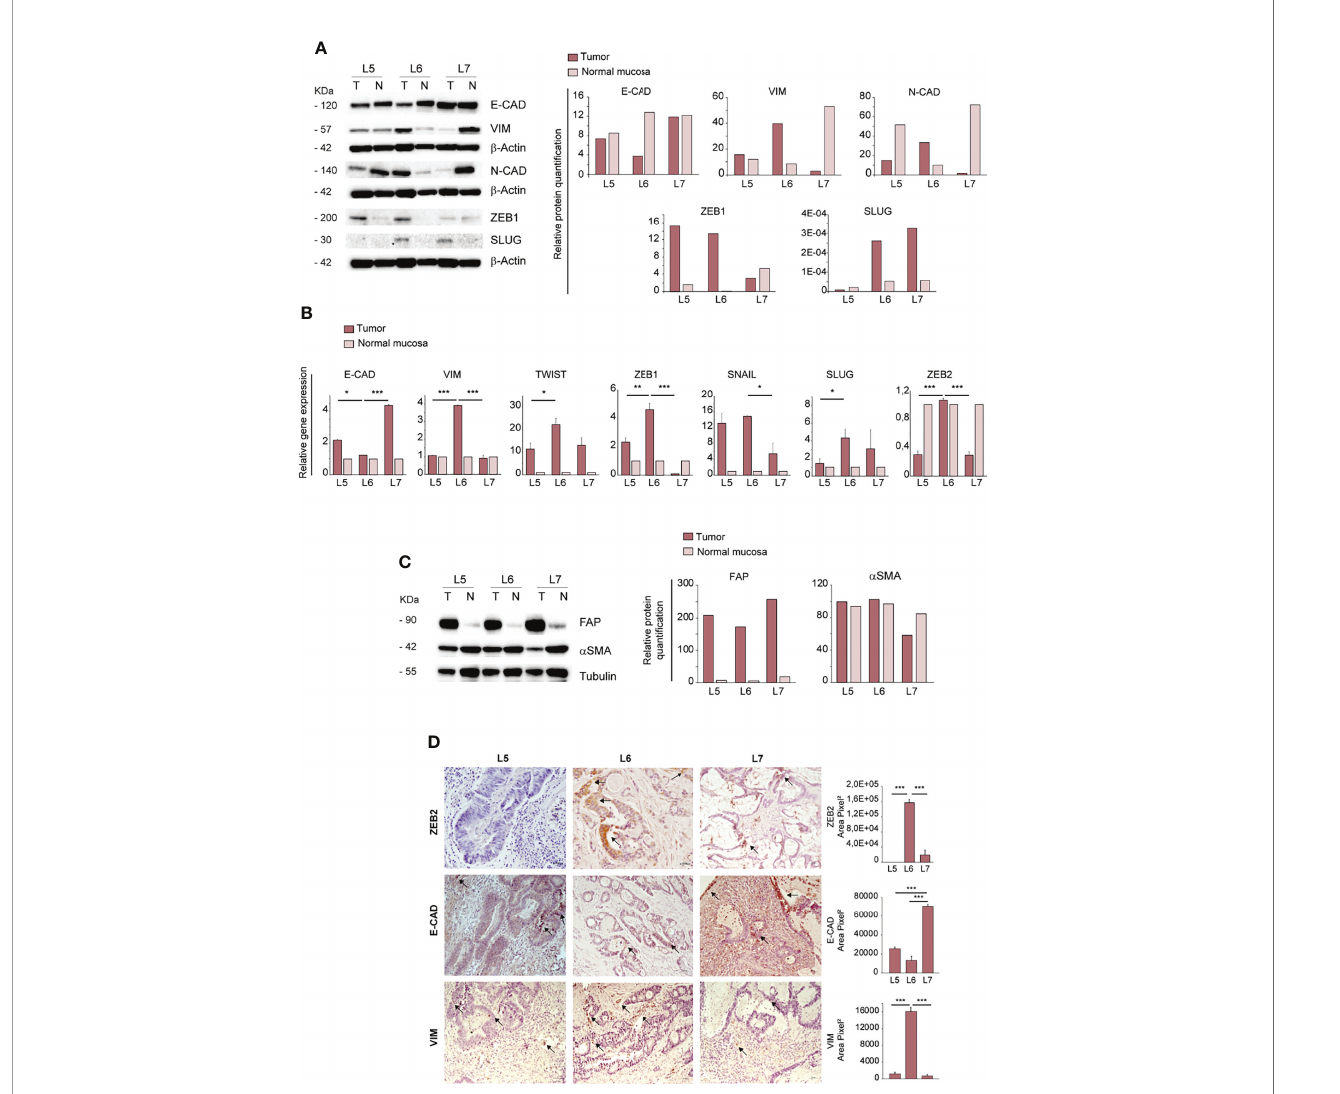
FIGURE 2 | Ortho-PDX generation is associated with a mesenchymal phenotype of the parental tumor. (A) Left: immunoblot analysis of E-Cadherin, Vimentin, N- Cadherin, ZEB1 and SLUG on whole lysates of normal mucosa (N) and patient tumors (T). b -Actin was used as a loading control. Right: quanti fi cation of the immunoblot experiment shown on the left. (B) qRT-PCR analysis of Vimentin, Twist, E-Cadherin, ZEB1, SNAIL, SLUG and ZEB2 expression in normal mucosa and tumor tissue of patient tumors L5, L6, L7. Mean ± SD of 3 experiments. *P<0.05, **P<0.01 and ***P<0.001 from two-tailed t test. (C) Left: Immunoblot analysis of Fibroblast Activation Protein (FAP) and alpha Smooth Muscle Actin ( a SMA) on normal mucosa (N) and patient tumors (T), with tubulin as loading control. Right: quanti fi cation of the immunoblot experiment shown on the left. (D) Left: Paraf fi n-embedded sections of patient tumors L5, L6, L7 were stained with anti-ZEB2 (upper panels), anti-E-Cadherin (E-CAD, central panels) and anti-Vimentin (VIM, lower panels). Arrows show areas positive for protein expression. Right: quanti fi cation of ZEB2, E-CAD and VIM performed on patients L5, L6, L7, 5 fi elds/section. Magni fi cation 20x. Bar 50 m